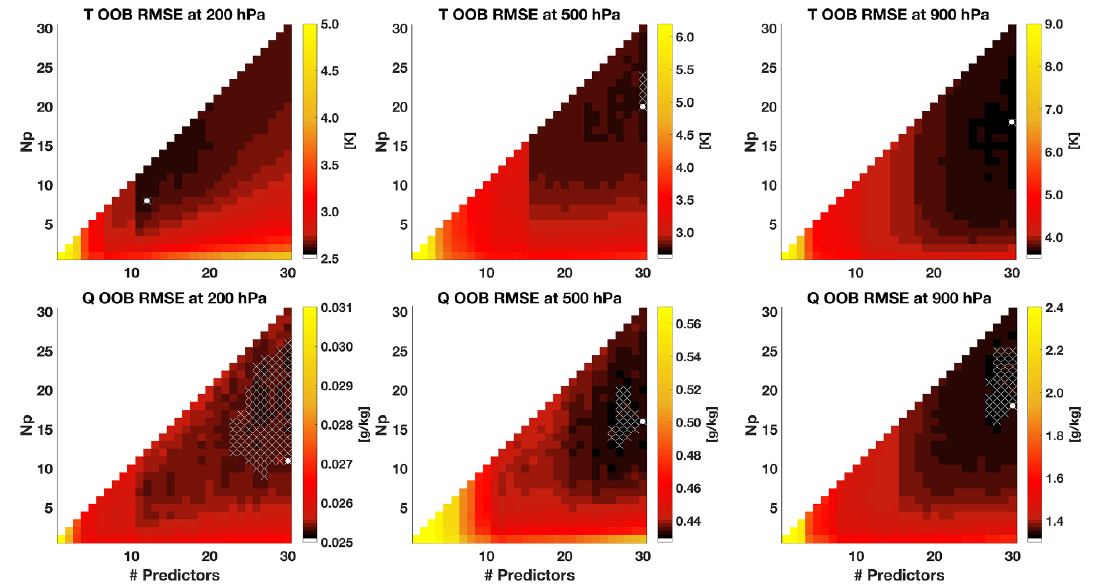
Figure 4. Predictor selection and Np parameter analysis for T ( top ) and Q ( bottom ) at three representative levels: 200 hPa ( left ), 500 hPa ( center ), and 900 hPa ( right ). The panels also show the out-of-bag (OOB) root mean square error (RMSE) minimum values found (white crosses) and the chosen OOB RMSE minimum, corresponding to the lowest value of Np (white circle).